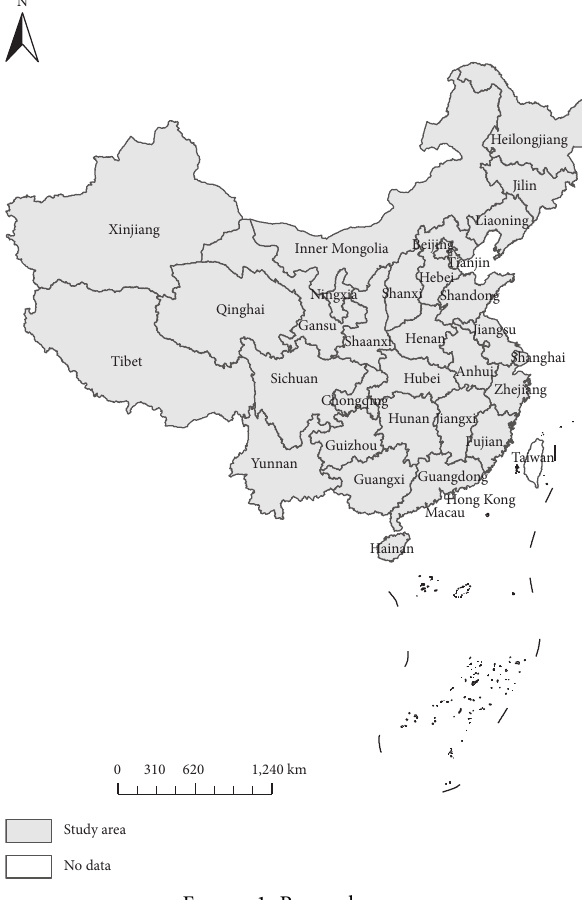
Figure 1: Research